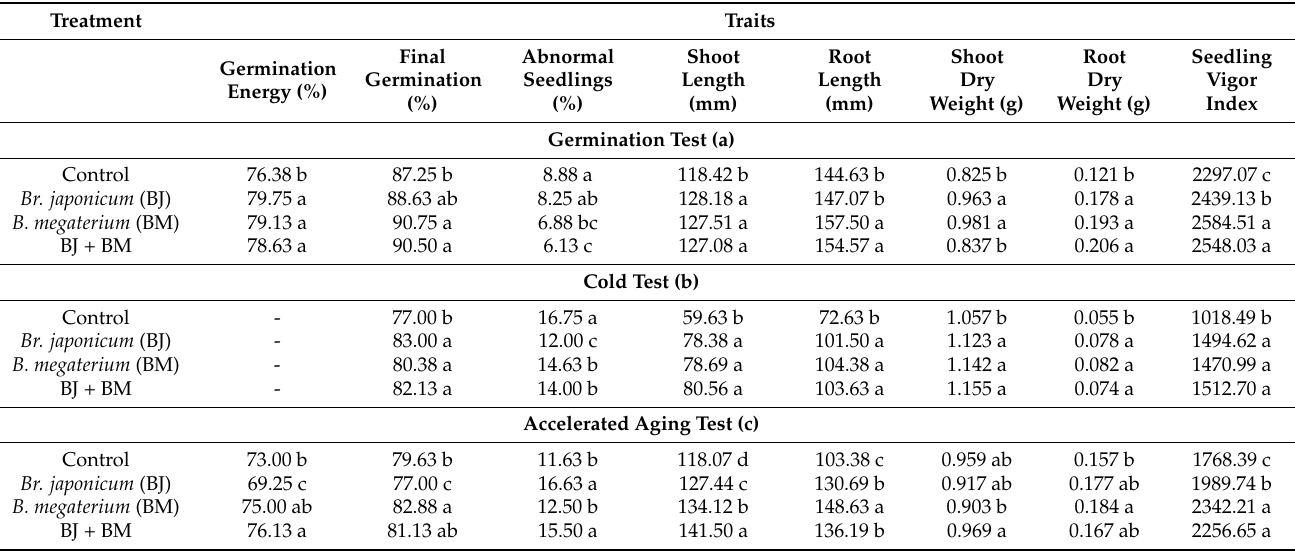
Table 4. Effect of seed bio-priming treatments on soybean parameters in different laboratory tests. ( a ) Germination Test; ( b ) Cold Test; ( c ) Accelerated Aging